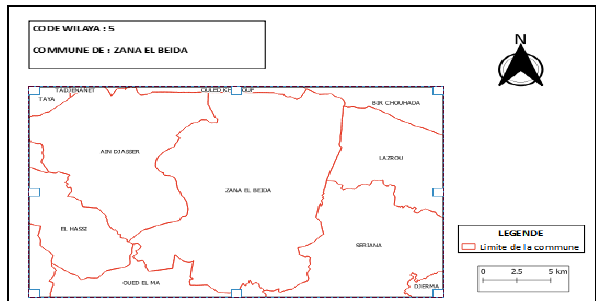
Figure 3 . An example of an atlas of the "units"